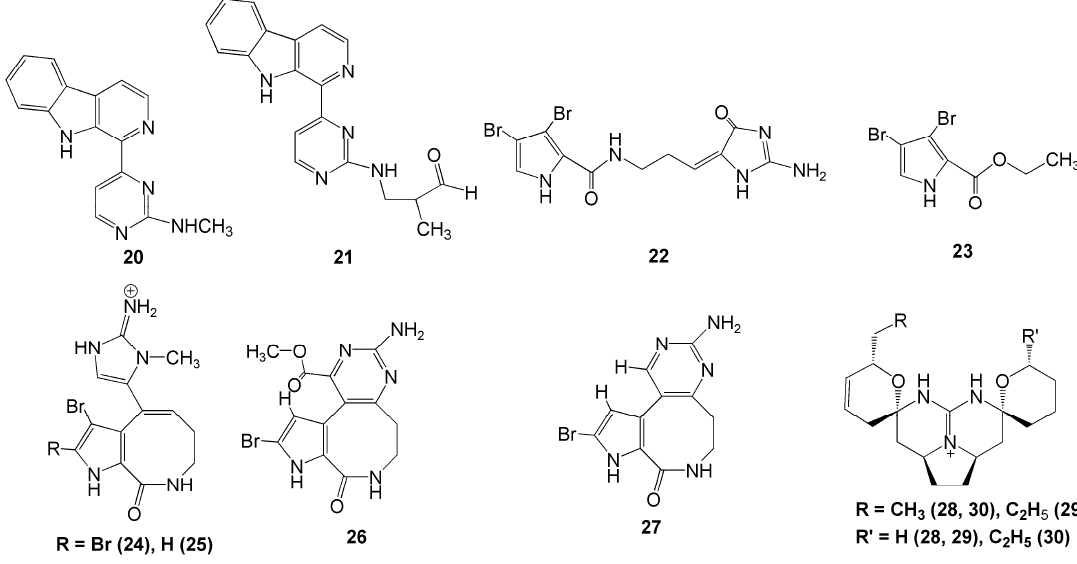
Figure 2. Chemical structures of 20–30.